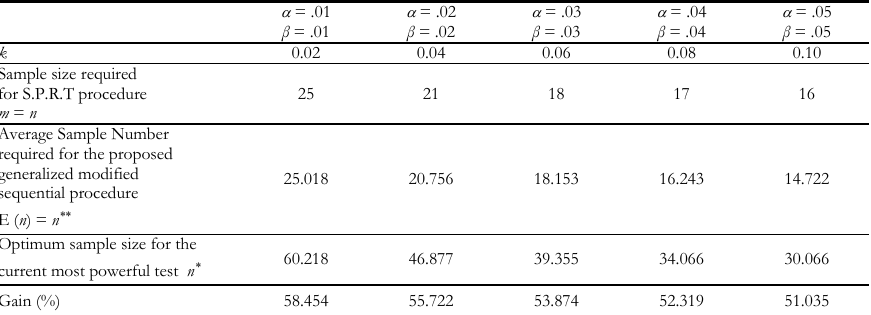
α = .01 α = .02 α = .03 α = .04 α = .05 β = .01 β = .02 β = .03 β = .04 β = .05